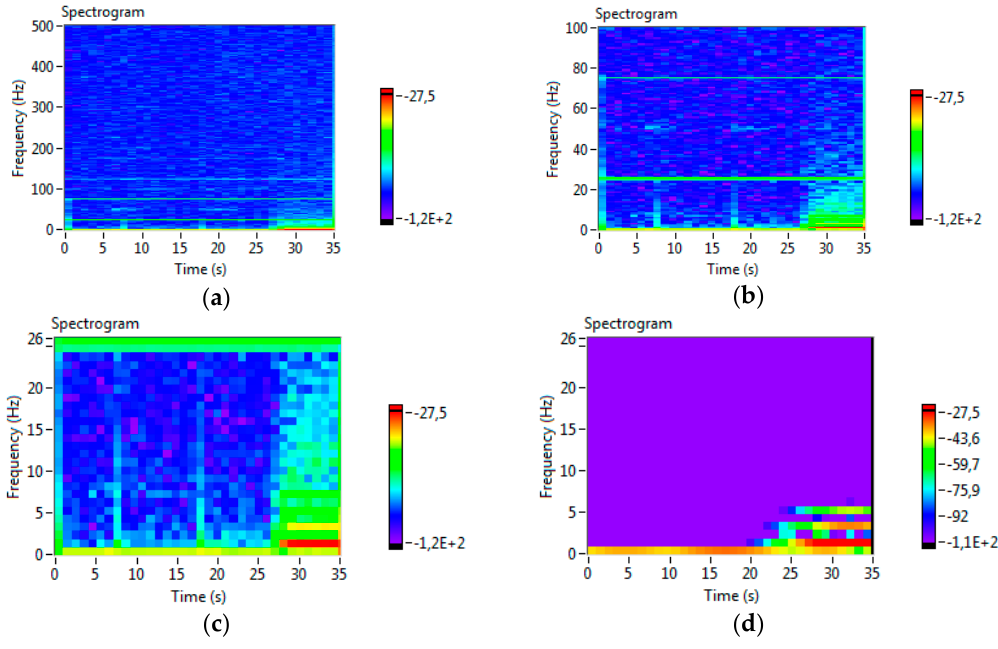
Figure 14. The adaptive spectrogram of the signal in the frequency range: ( a ) up to 500 Hz; ( b ) up to 100 Hz; ( c ) up 26 Hz; and ( d ) up to 26 Hz after the rejection of the chirplets of low energy.